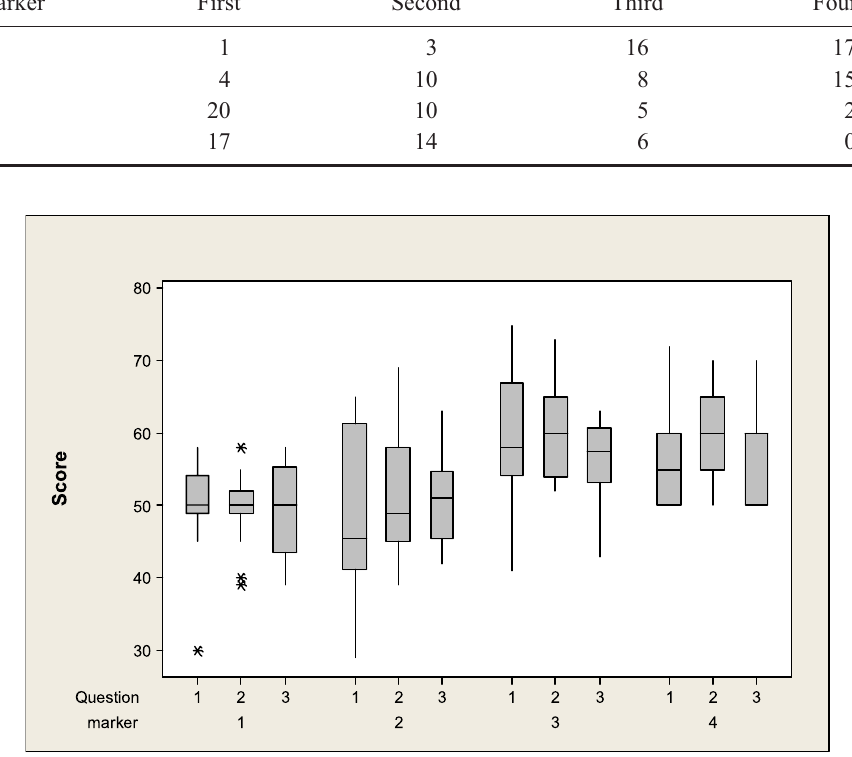
Figure 3. Boxplot of score by marker then